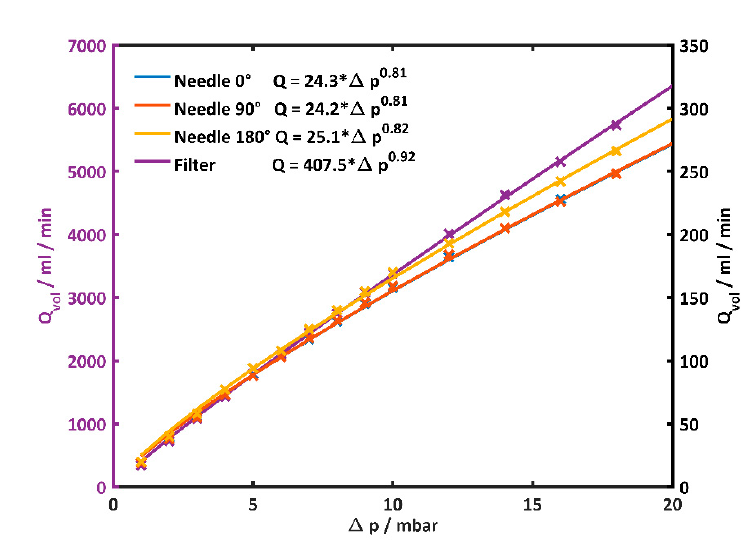
Figure 3. Flow rate as a function of total pressure drop for different needle orientations (right y ‐ axis) and the HEPA filter (left y ‐